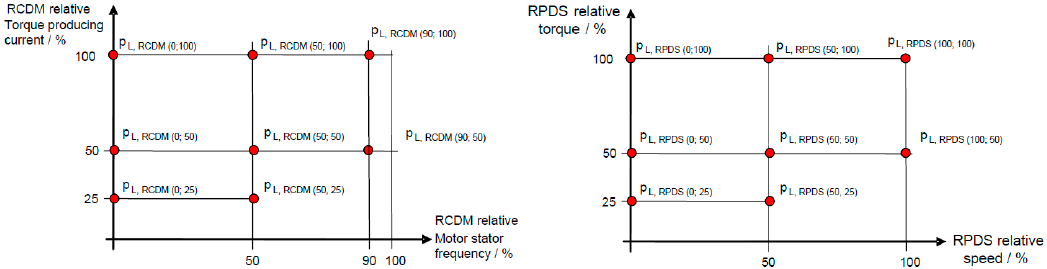
Figure 3. Illustration of the operating points (shaft speed and torque) for the determination of the relative losses of the Complete Drive Module (CDM) and Power Drive System (PDS) as set in IEC 61800-9-2 ed.1.0 [7]. Copyright © 2017 IEC Geneva, Switzerland. www.iec.ch